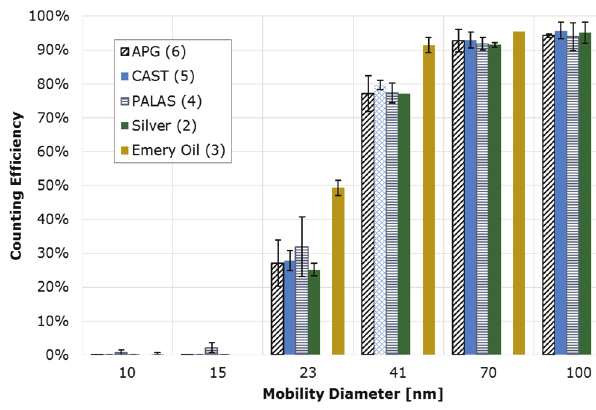
Fig. 2. Calibration results of the golden CPC with various particle genera- tors across Europe. Number in brackets indicates number of laboratories [21]. APG = AVL Particle Generator (thermally stable